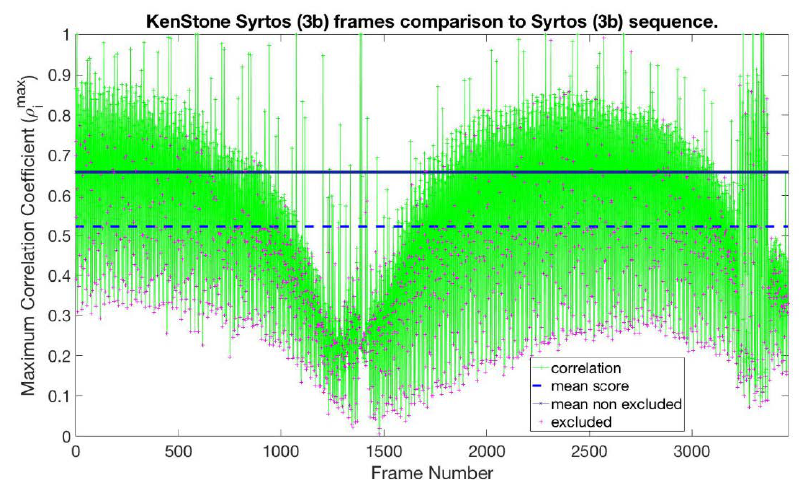
Fig. 4 Comparison of accuracy of rehearsal of specific action segments in high-dynamic dance